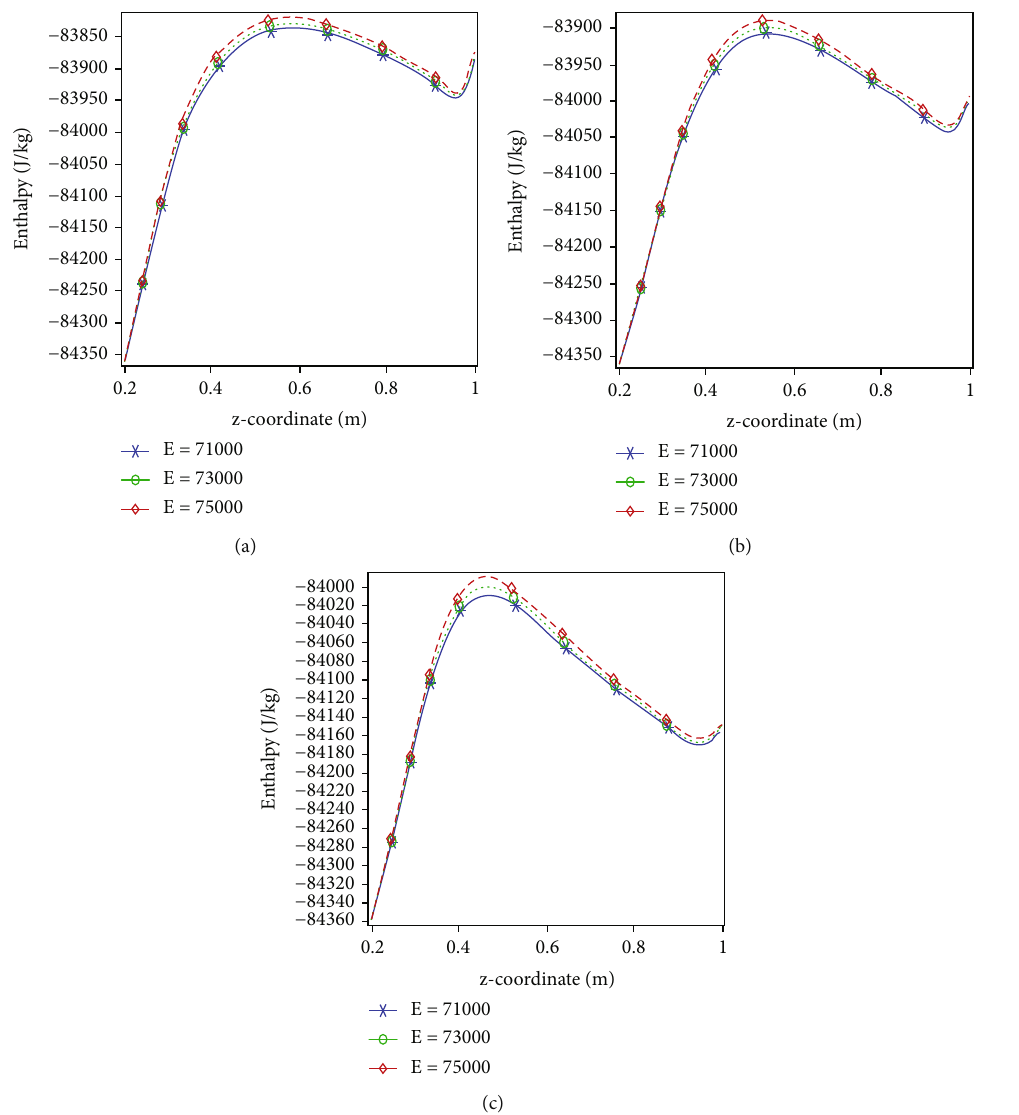
Figure 14: Measurement of enthalpy at downstream along the backstep channel against the axial direction at (a) Re = 100 , I : C = 1 % , a = 0 : 5 ; (b) Re = 100 , I : C = 1 % , a = 0 : 6 ; and (c) Re = 100 , I : C = 1 % , a = 0 : 7